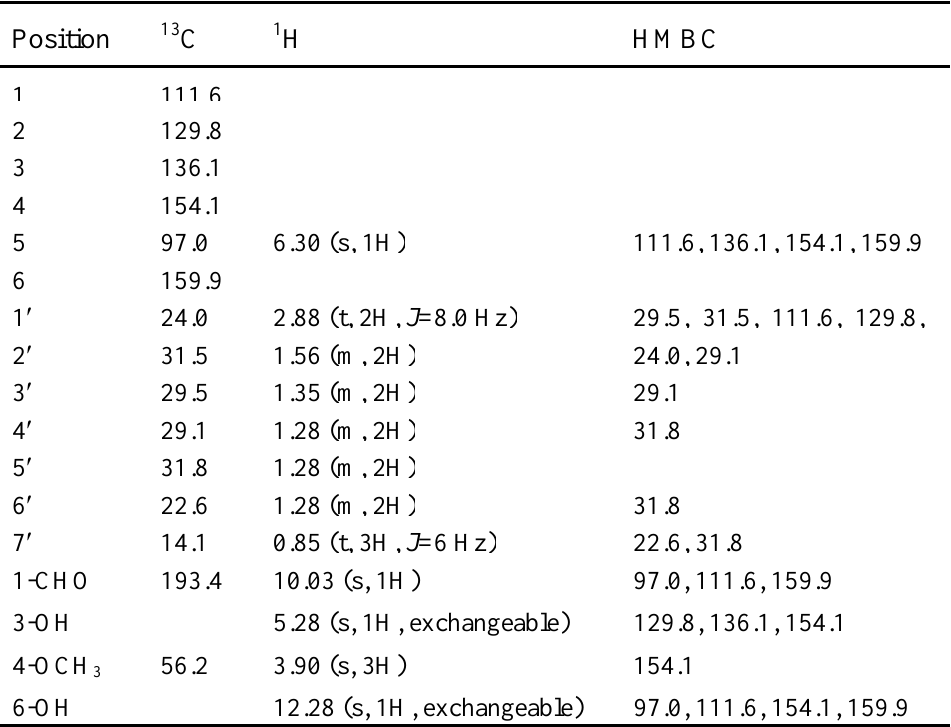
NMR spectral data of compound 1 (CDCl